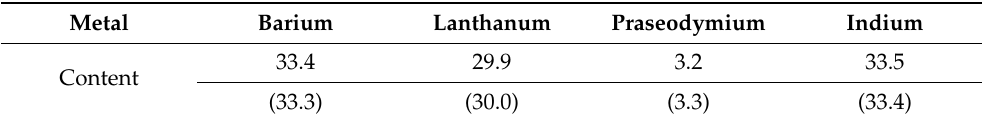
Table 2. The good agreement between theoretical and experimental values was confirmed. Table 2. The results of the energy-dispersive analysis for the composition BaLa 0.9 Pr 0.1 InO 4 (theoretical values in atomic % are provided in the